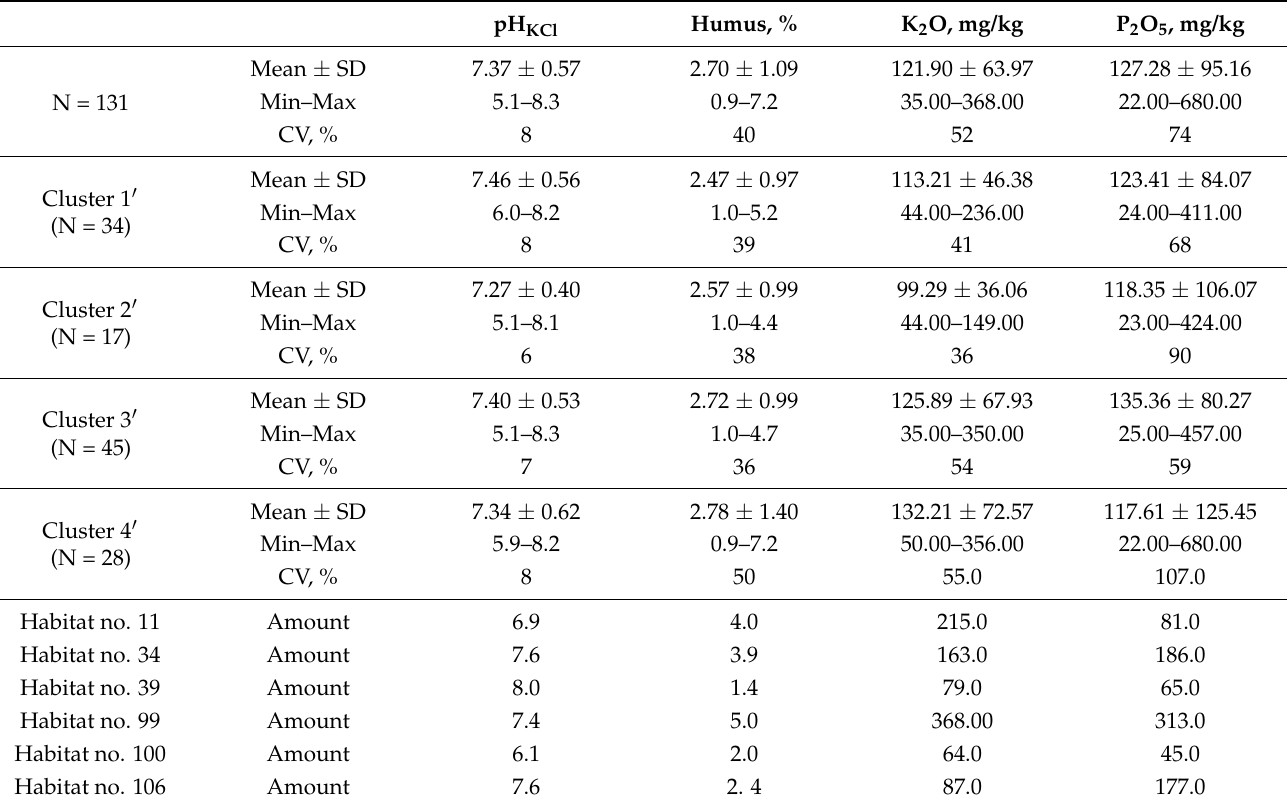
Table 3. Descriptive statistics of pH KCl , humus, mobile potassium (K 2 O), mobile phosphorus (P 2 O 5 ) in distinguished clusters of Thymus pulegioides habitats and habitats no. 11, no. 34, no. 39, no. 99, no. 100 and no. 106. pH KCl Humus, % K 2 O, mg/kg P 2 O 5 ,